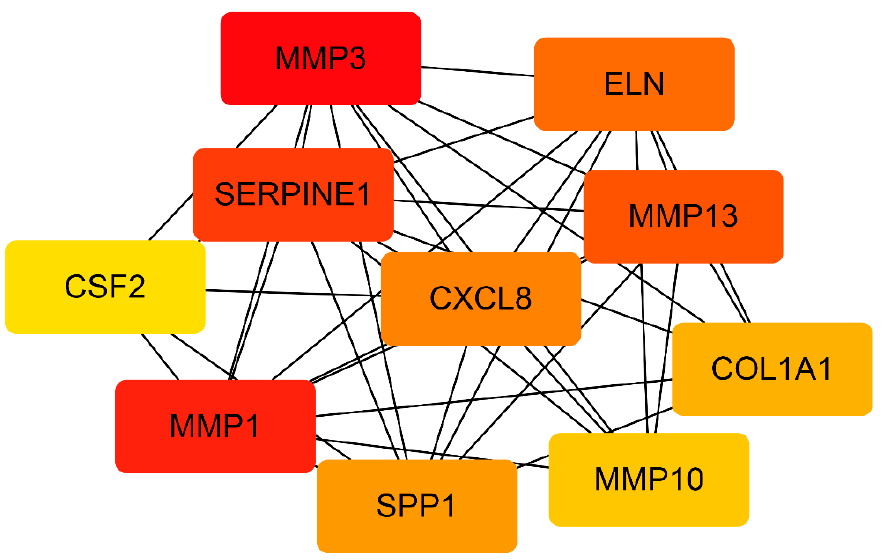
Figure 6. The top 10 hub genes in the PPI network of the upregulated DEGs and their interaction relationships (the darker red represents higher node degree).